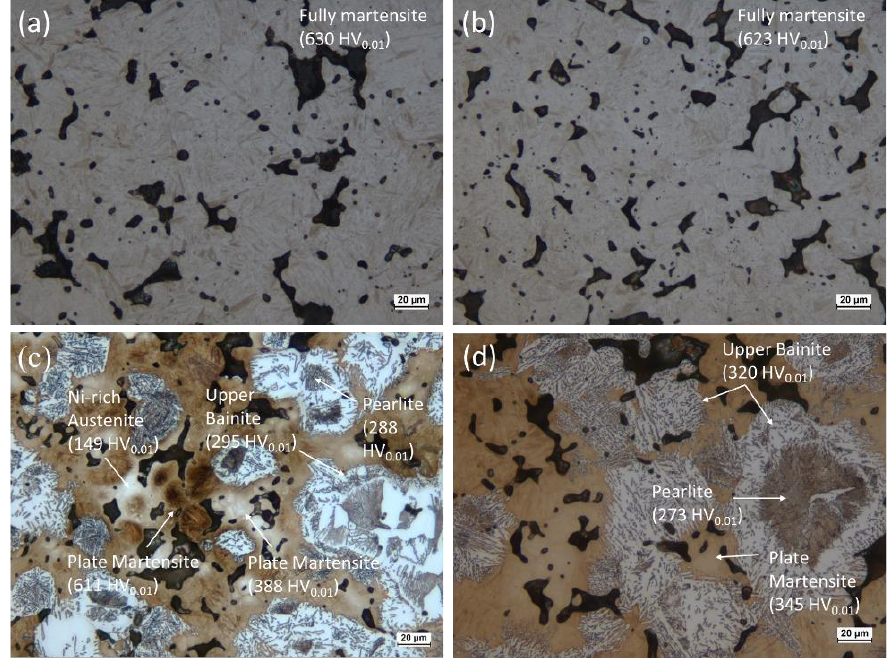
Figure 5. Porosity and phase of Astaloy CrM steel sintered at ( a ) 1120 °C and ( b ) 1250 °C and Dis- taloy AE alloy sintered at ( c ) 1120 °C and ( d ) 1250 °C.